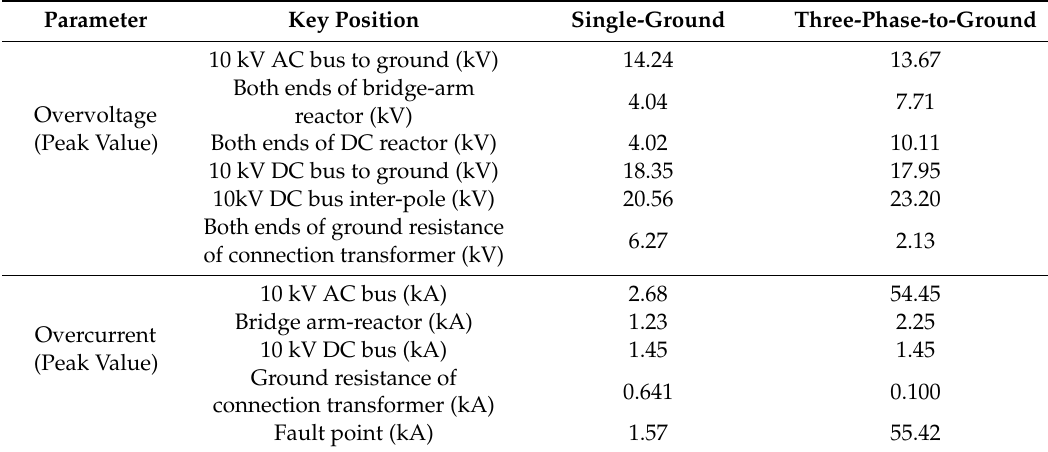
Table 7. Overvoltage and overcurrent levels during the 10 kV AC system side fault.